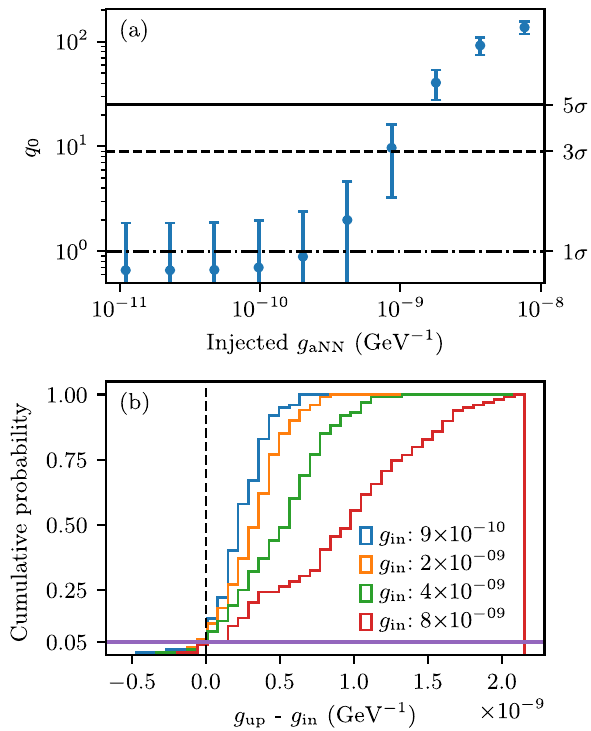
FIG. 12. (a) q 0 as a function of the injected g for the case of aNN a 10-Hz axion. The marker denotes the average of the q 0 test statistic recovered from 100 independent Monte Carlo simula- tions, while the error bars denote the corresponding standard deviation. Horizontal lines with labels of 1 σ , 3 σ , and 5 σ on the FIG. 13. Left: comparison of the 95% upper limit obtained via right indicate the significance of obtaining a particular value of q 0 the frequency-domain approach of this paper (orange) and the (see Sec. II B for more details). (b) Empirical cumulative time-domain approach of Ref. [31] (blue) over a small frequency distribution of the recovered 95% upper limit g for the case range of the experimental data in the vicinity of 0.525 Hz. Note up that the calculations are completely independent and that there is of a 10-Hz axion where the injected g is above the null limit (see in some misalignment of the frequency grids. Right: histogram of Fig. 11). As expected, the recovered limits are below the injected g the obtained limits in the frequency range of the left for approximately 5% of the time. in